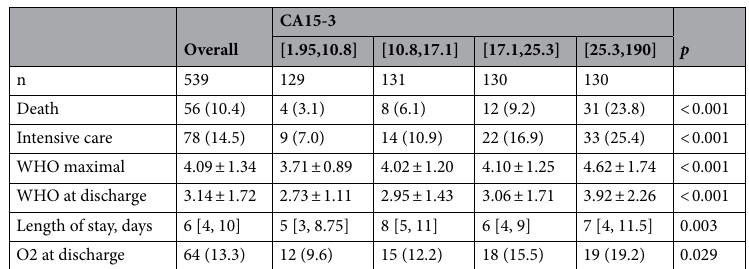
Table 2. Distribution of clinical end-points by quartiles of concentrations of CA